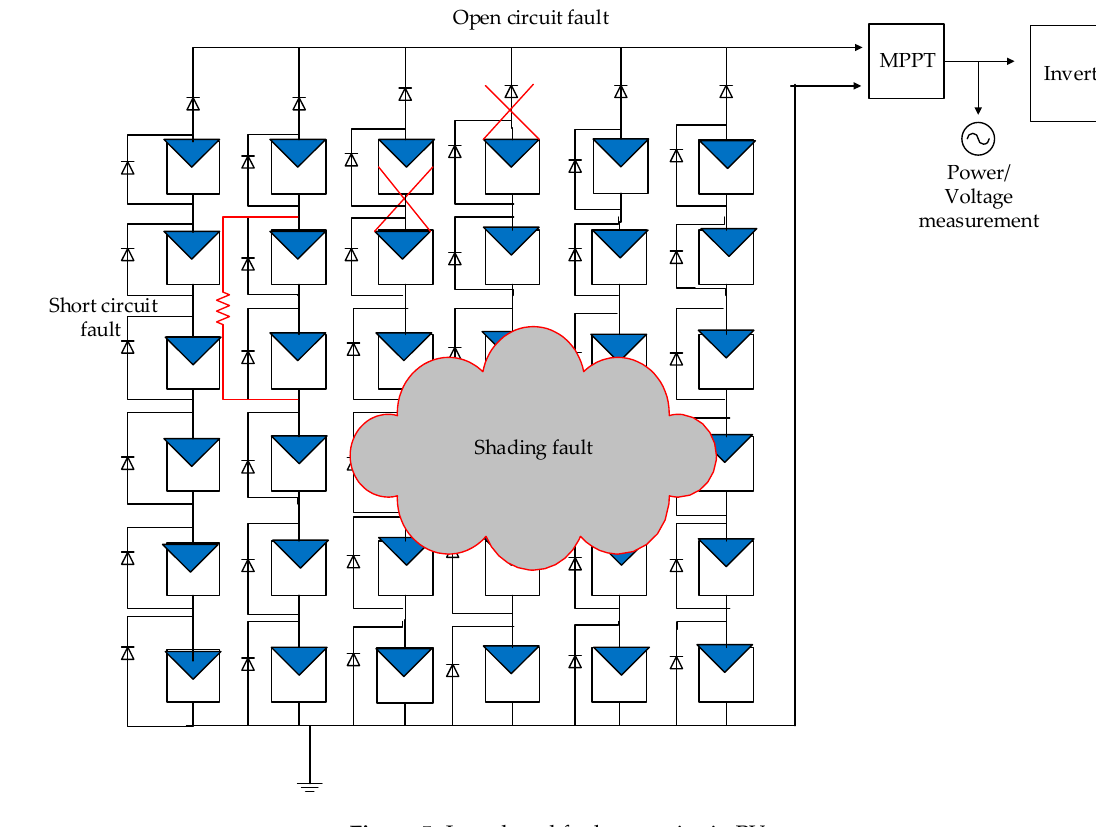
Figure. 5. Introduced fault scenarios in PV array. Figure 5. Introduced fault scenarios in PV